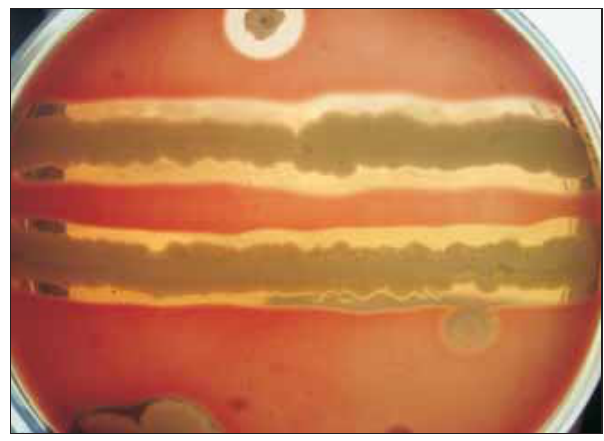
Figure-2: E. coli showing alpha hemolysis on washed sheep blood